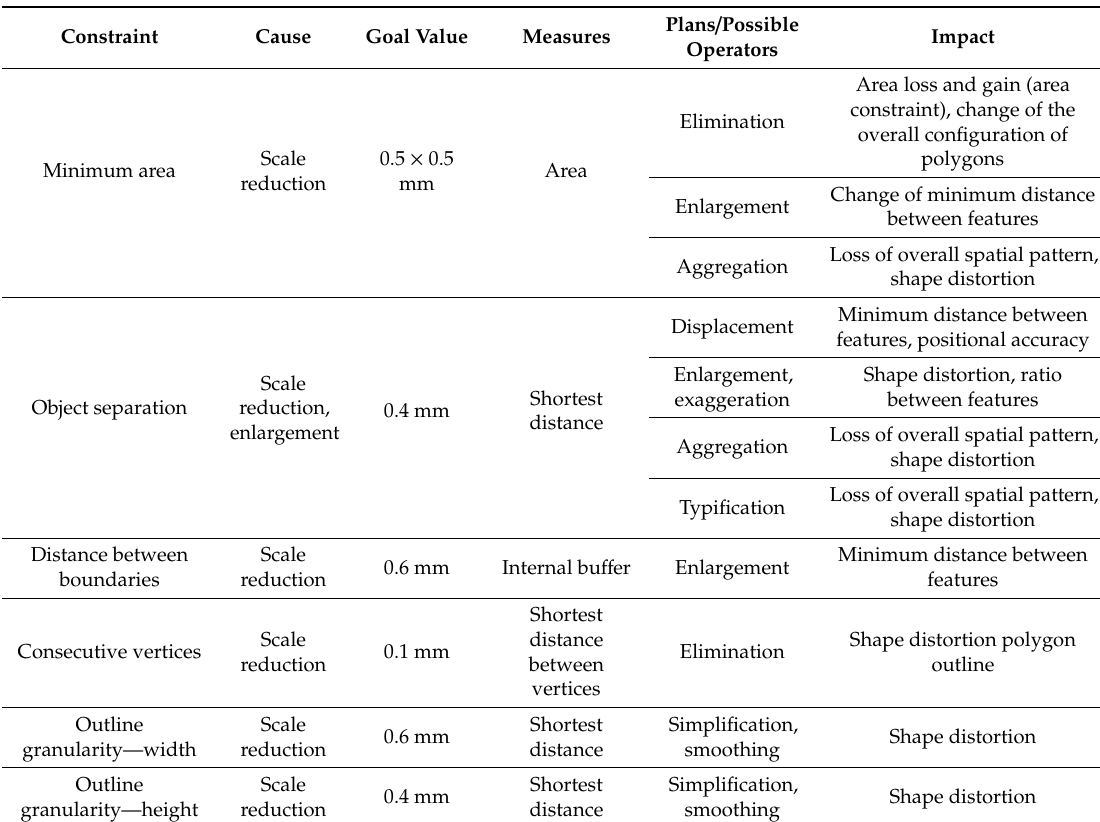
Table 1. List of size constraints and associated elements. Goal values are taken from [30] but could be modified (cf. Section